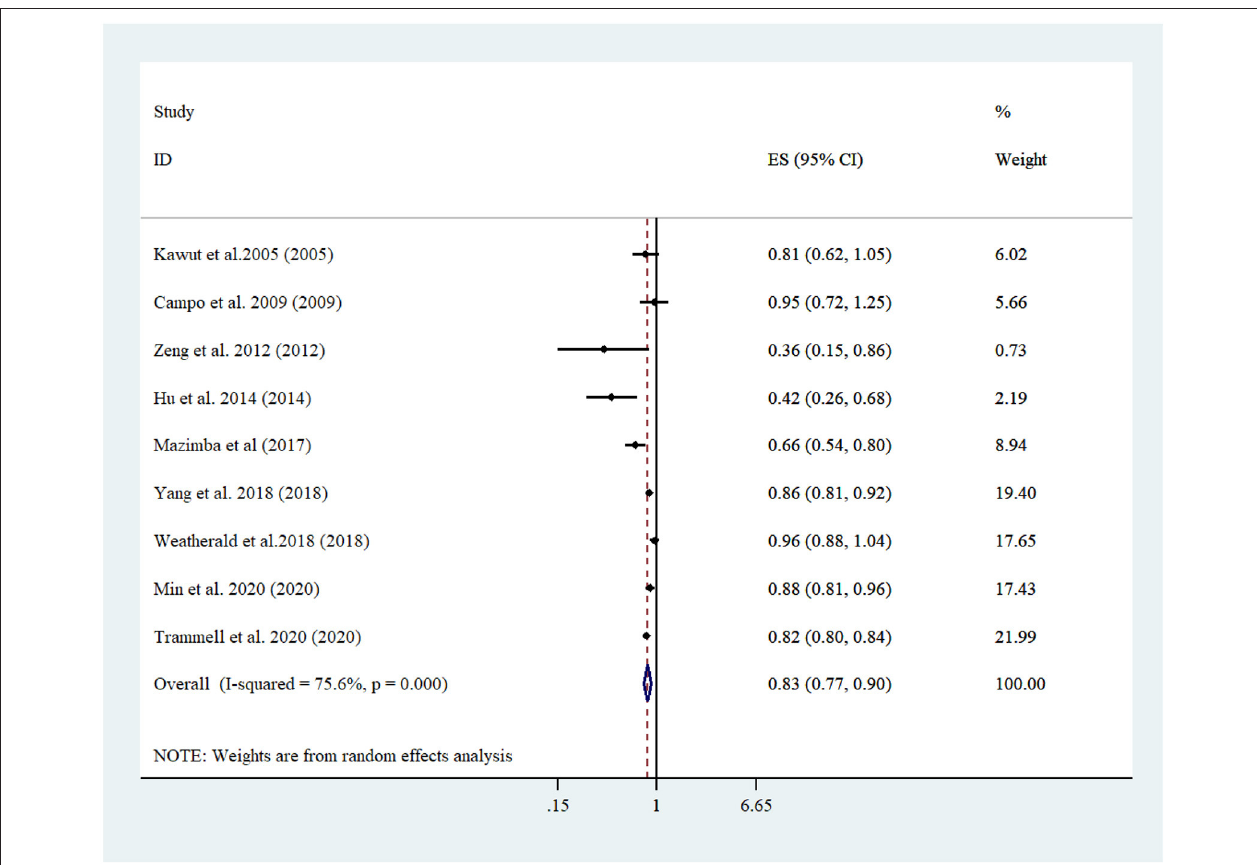
FIGURE 2 | Forest plot derived from random-effects meta-analysis of studies investigating the association between 5-unit increment in body mass index and mortality among pulmonary hypertension patients. CI, confidence interval; ES, effect size.